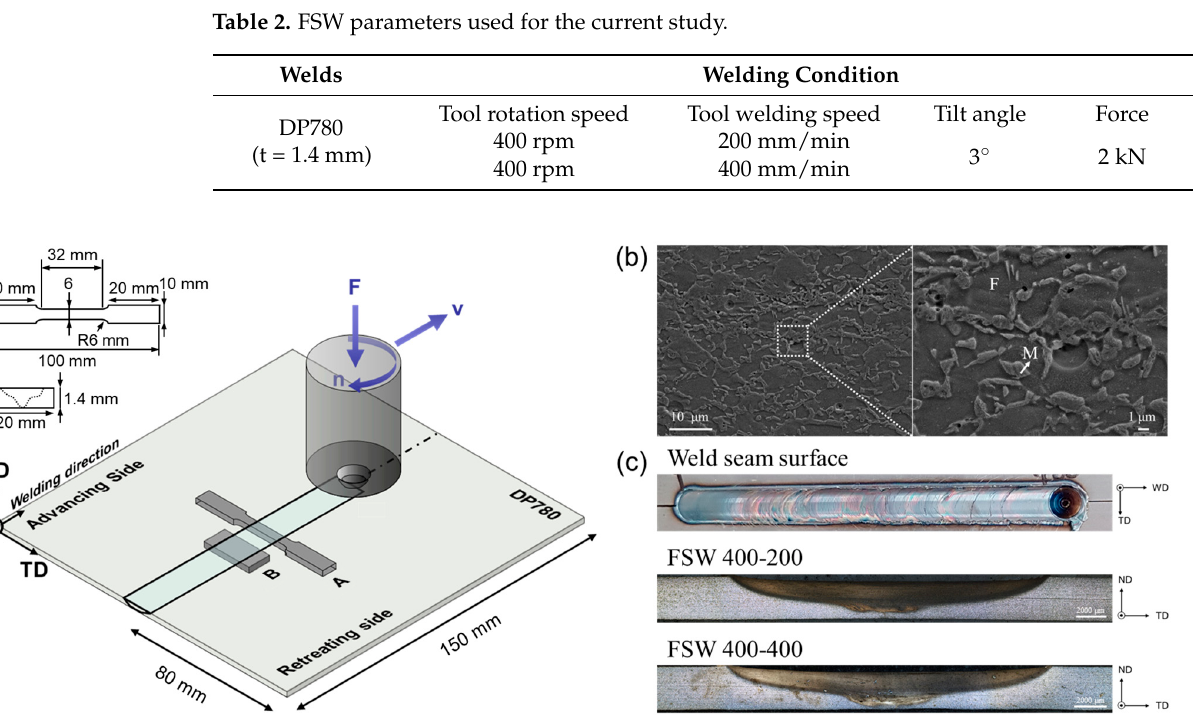
Table 2. FSW parameters used for the current study.